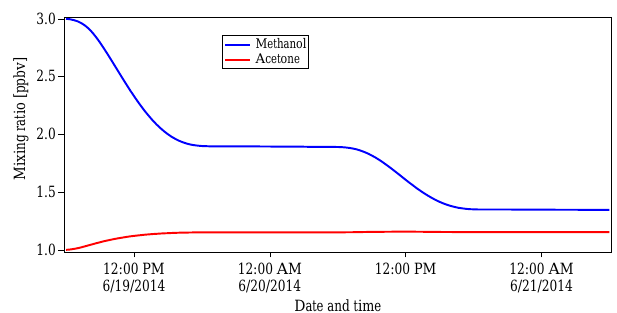
Figure 7. Ozone in ppbv, relative humidity in % and solar radiation in Wm − 2 (10min mean values). The red data points are influenced by air masses from the residual layer/free troposphere.